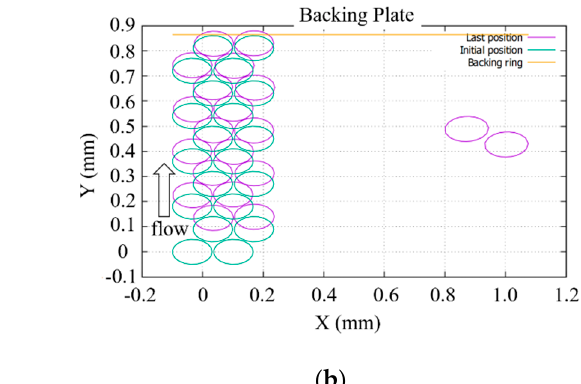
Table 1. Geometric parameters for the baseline